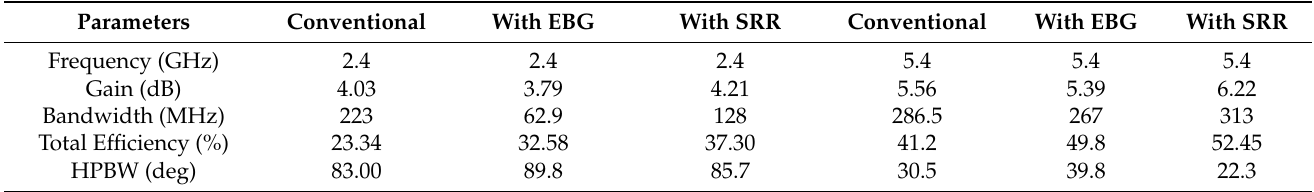
Figure 20. 3D radiation patterns in bent scenarios (on-body). ( a ) Conventional antenna at 2.4 GHz. ( b ) Conventional antenna at 5.4 GHz. ( c ) EBG-based antenna at 2.4 GHz. ( d ) EBG-based antenna at 5.4 GHz. ( e ) SRR-based antenna at 2.4 GHz. ( f ) SRR-based antenna at 5.4 GHz. Table 7. Summary of results (conventional vs. EBG-based vs. SRR-based) of bent antennas on human